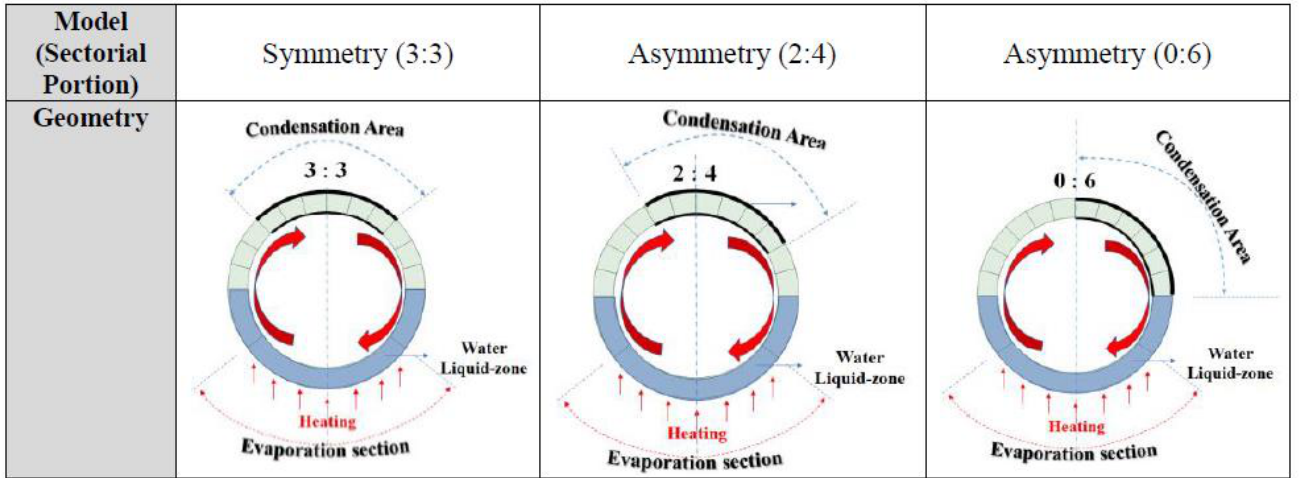
Figure 5. Concept of symmetry and asymmetry in 2D modeling.